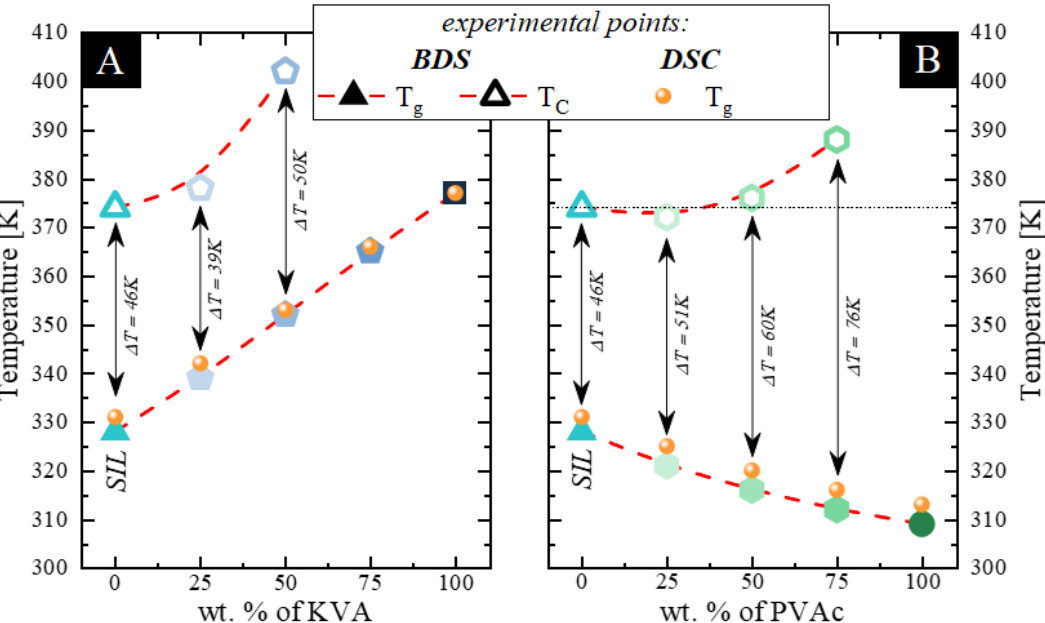
Figure 6. Experimental data determined by broadband dielectric spectroscopy (BDS). ( A , B ) present the temperatures of the crystallization onset (empty symbols) as well as the glass transition temperatures (full symbols) of SIL–KVA and SIL–PVAc ASDs, respectively. Red dashed lines are present to help visualize the trend. Data regarding the neat SIL was taken from [49].